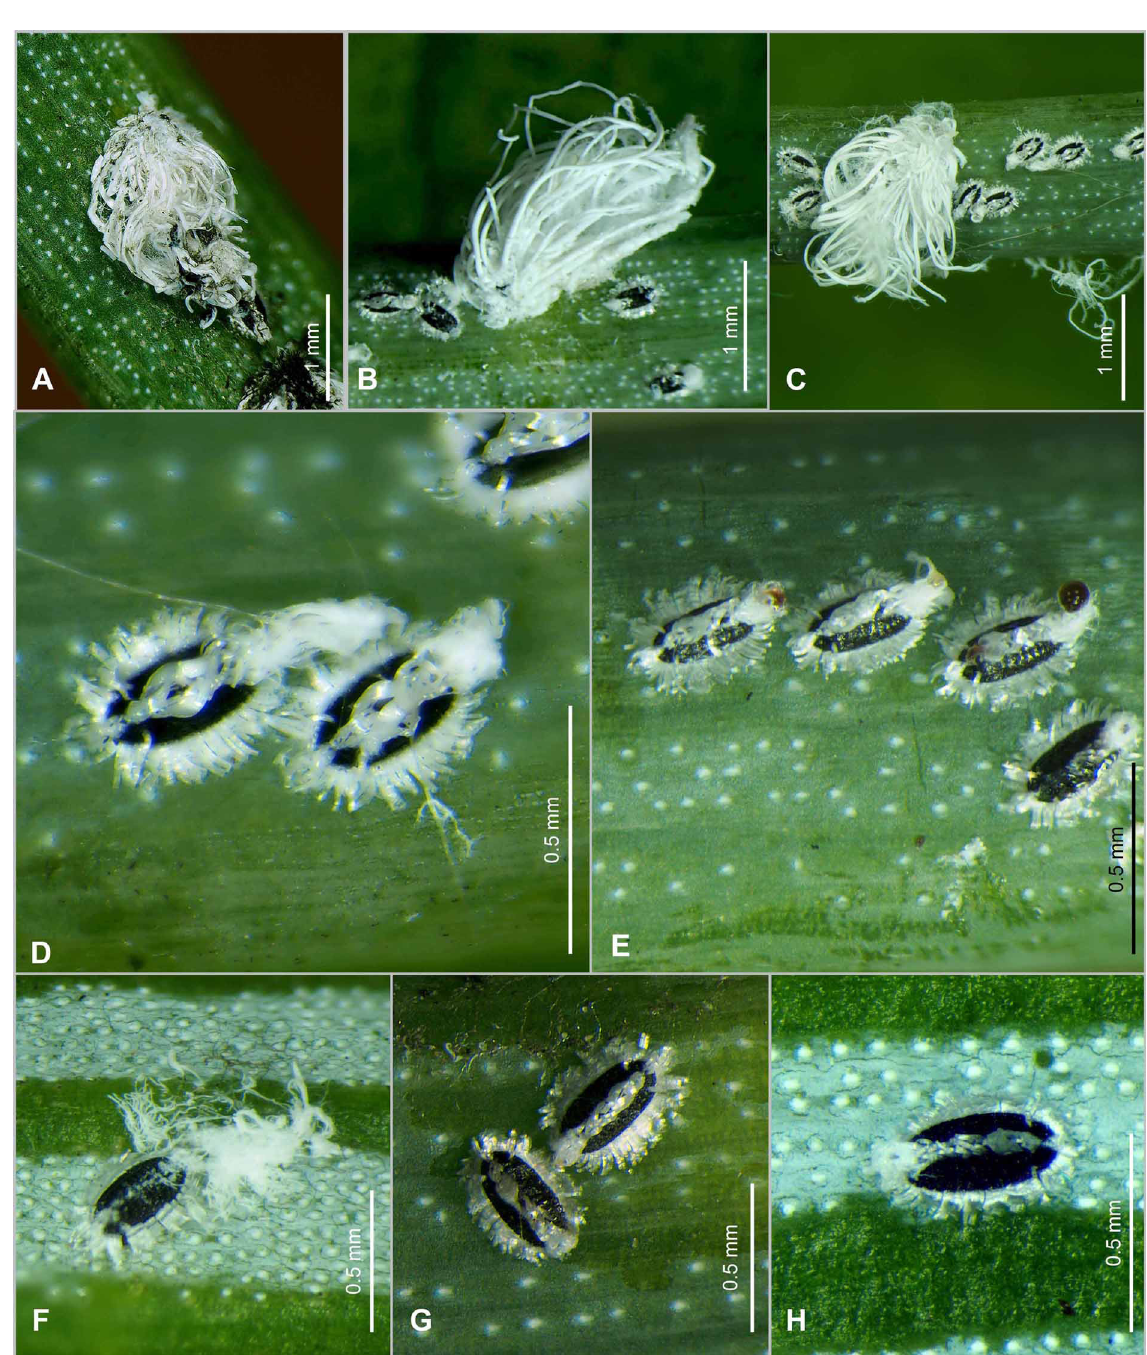
Fig. 43. Adelges (Aphrastasia) pectinatae (Cholodkovsky, 1888) on needles of Abies concolor . A–C . Apterae with first instar hibernating nymphs (neosistens). D–H .